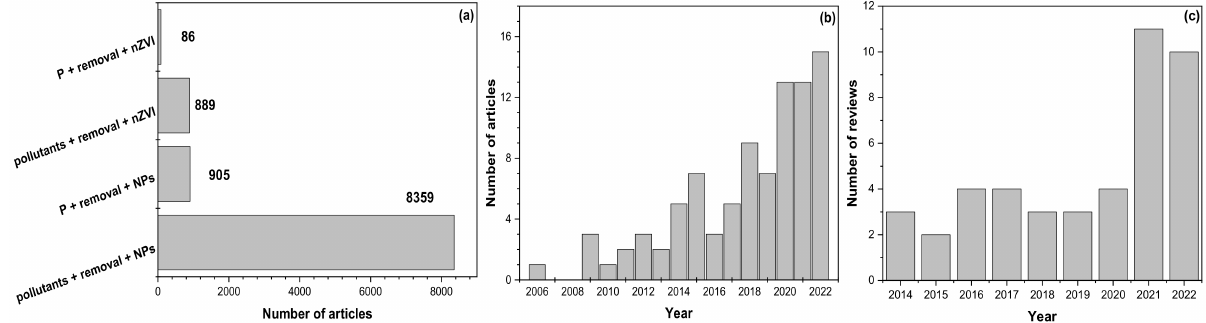
Figure 1. Search performed in the Scopus database (9 December 2022) using the words ( a ) phos- phate (P), removal, nanoscale zero-valent iron (nZVI), pollutants, and nanoparticles (NPs). Increase in the number of articles by year based on words ( b ) P, removal, and nZVI. Increase in the number of reviews by year based on words ( c ) pollutants, removal, and